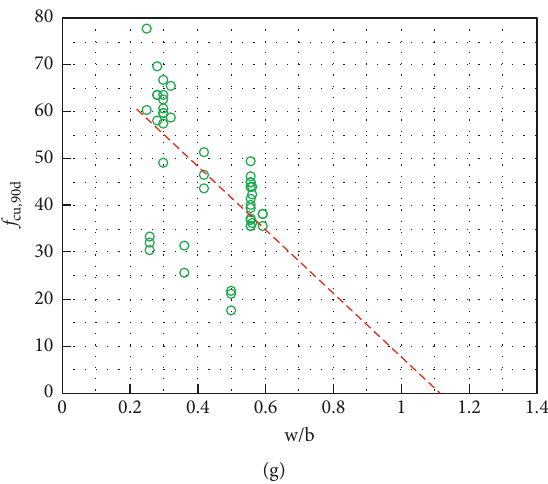
Figure 4: Effect of w/b on f cu,N. (a) At 3 days. (b) At 7 days. (c) At 14 days, (d) At 21 days. (e) At 28 days. (f) At 60 days. (g) At 90